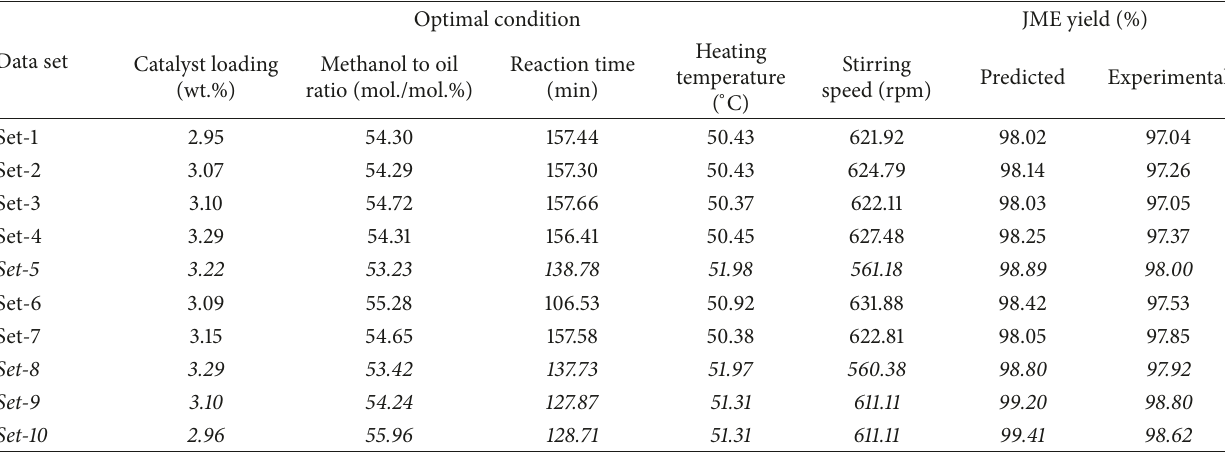
Table 5: Predicted JME yield % data sets validation at optimal conditions with experimental results.